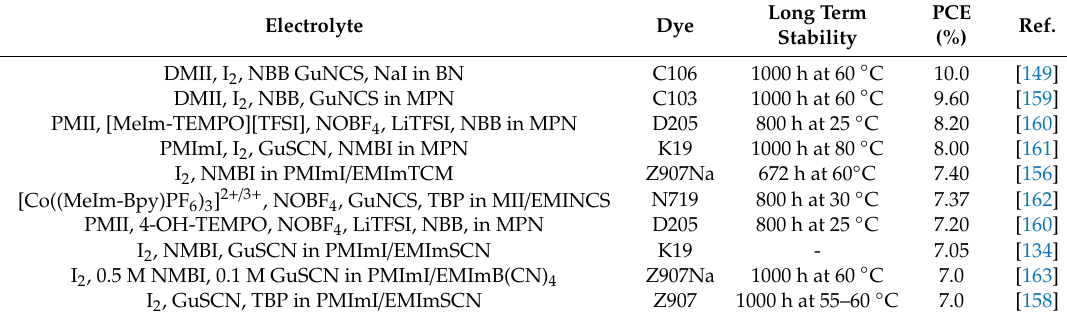
Table 3. Best e ffi ciencies reported with ionic liquid-based